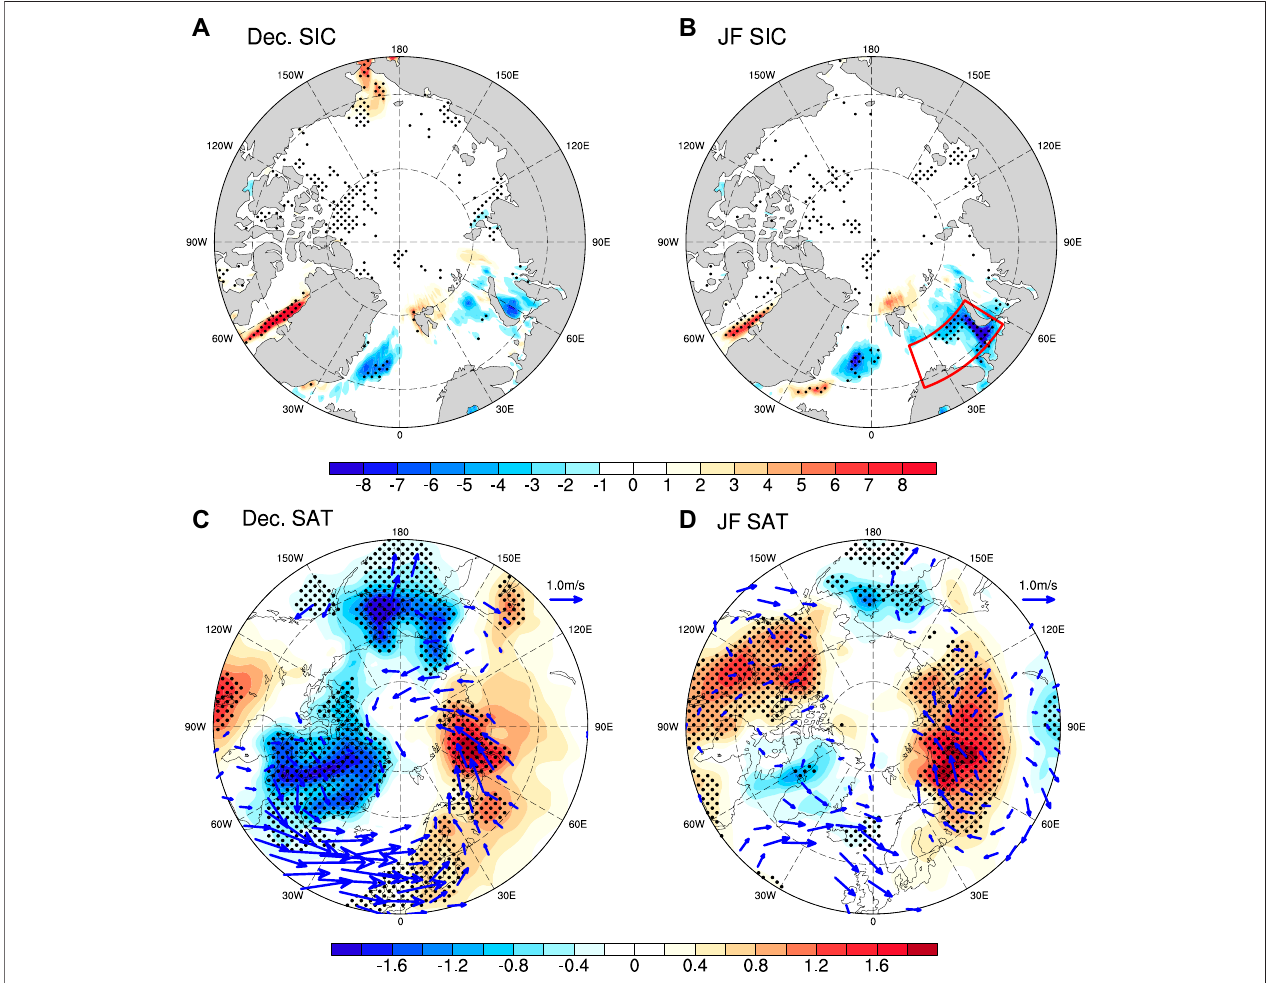
FIGURE 6 | Regressions of December (A) Arctic sea ice concentration (SIC; %) and (C) surface air temperature (SAT; ° C) and surface winds (m s − 1 ) against the negative October SNOWI during 1979 – 2017. (B) and (D) are the same as (A) and (C) , but for January – February. Stippled regions indicate that the anomalies are signi fi cant at the 90% con fi dence level. Wind vectors that are signi fi cant at the 90% con fi dence level are shown. The box in (B) indicates the region used to de fi ne the